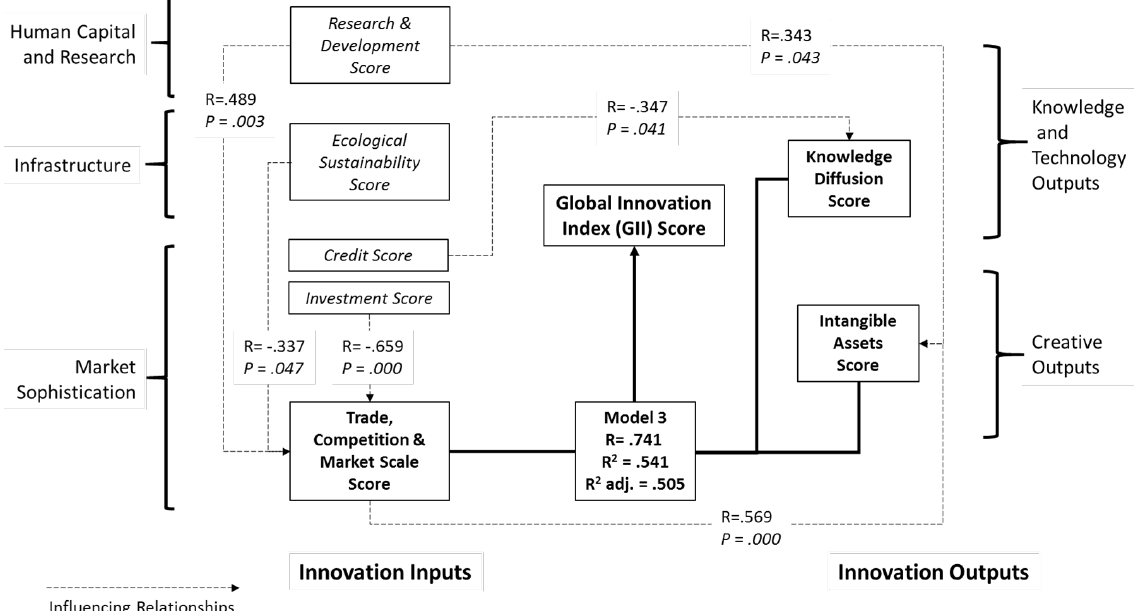
Fig. 2. Innovation drivers influencing predictive Model